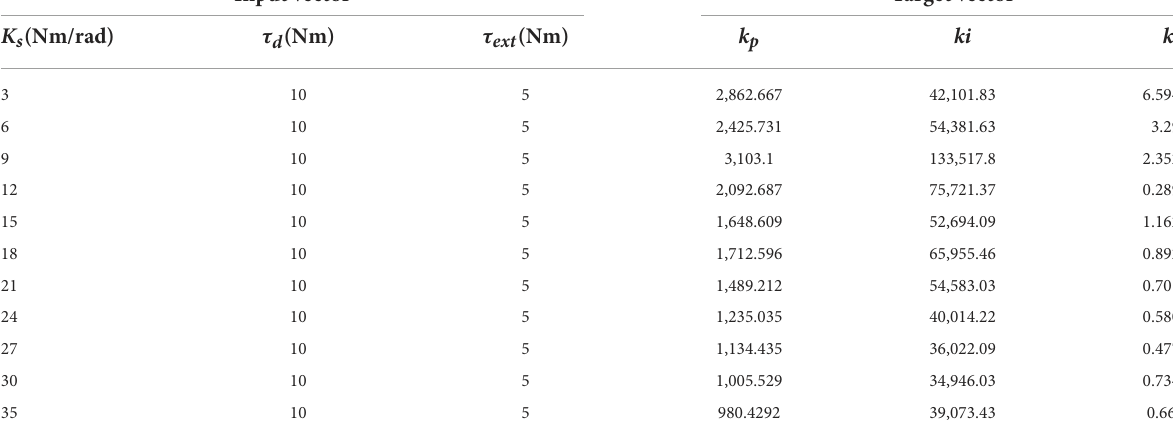
TABLE 1 Partial input vector and target vector